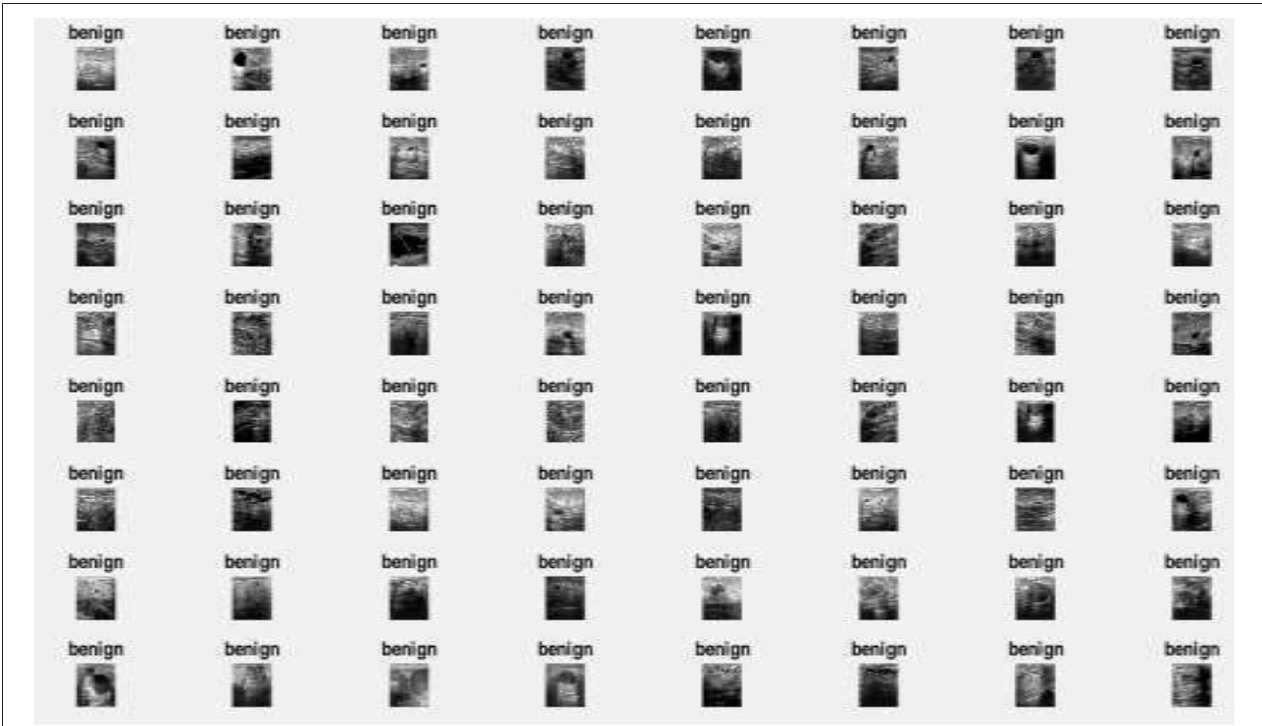
FIGURE 5 | Image classification of dataset A.